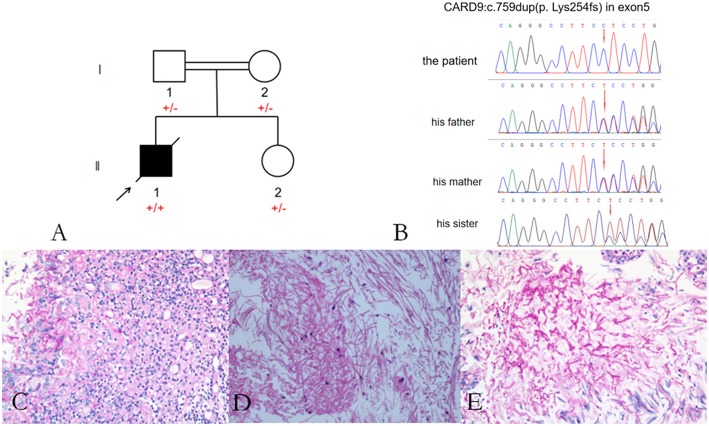
Pedigree of the patient with Exophiala dermatitidis infection and a CARD9 mutation: Square indicates male; circle indicates female; filled symbol indicates affected individual; diagonal line across the symbol indicates deceased individual; arrow indicates the proband (A); A novel c.759dup (p. Lys254fs) mutation was identified in the exon 5 of CARD9
(B); Histological features of the brain tissue biopsy (C–E): Hematoxylin-eosin H-E staining shows fungal granuloma (C), magnification ×200] and mycelia [(D), magnification ×400]. PSA staining shows mycelia (E). Abbreviations are as follows: +, mutation; –, wild-type.